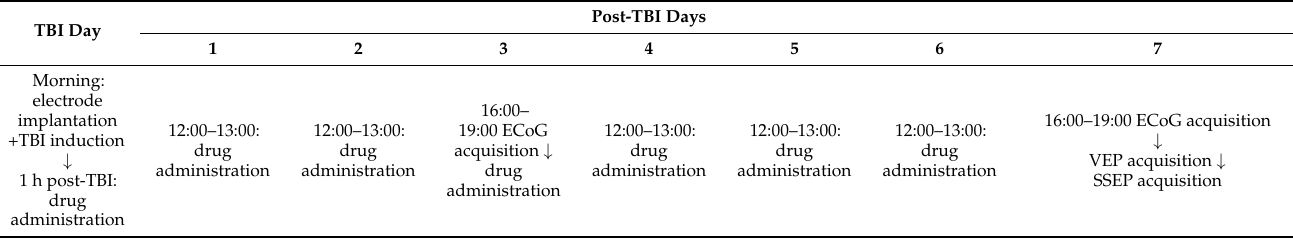
Table 1. Experimental